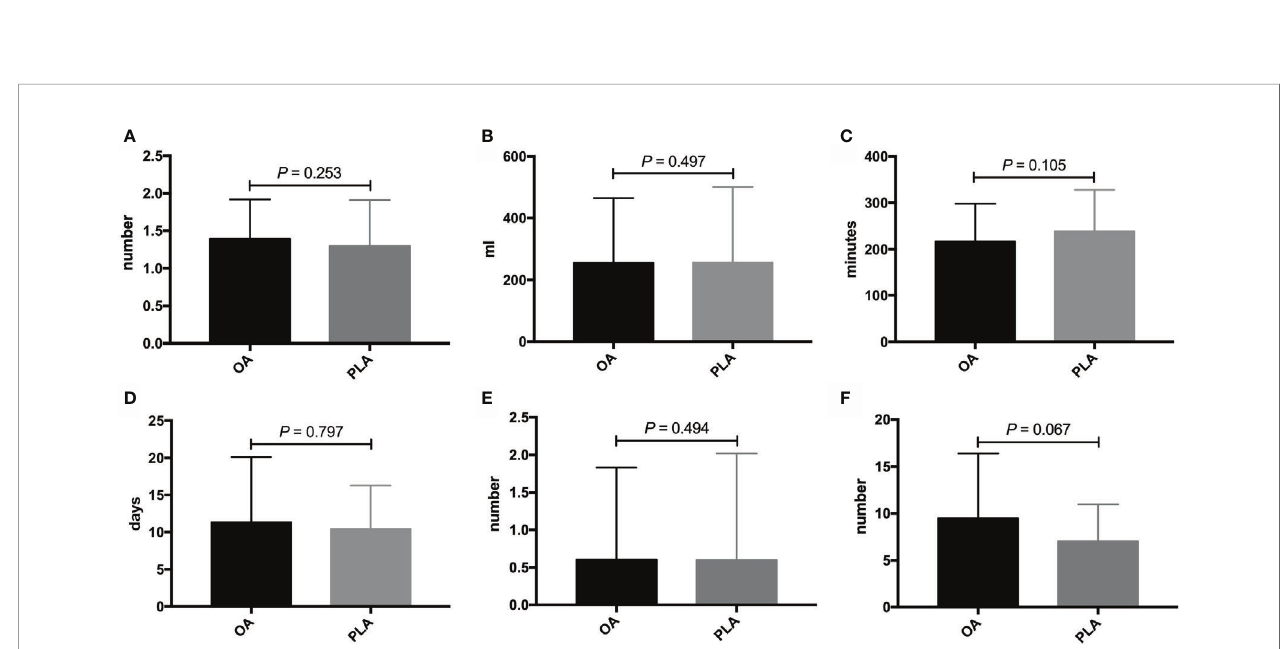
FIGURE 5 | Comparisons of secondary outcomes after OA or PLA in GBC patients. The difference of (A) intraoperative drainage placement, (B) intraoperative blood loss, (C) operation time, (D) postoperative hospitalization, (E) positive LNs, and (F) total harvested LNs. OA, open approach; PLA, primary laparoscopic approach; GBC, gallbladder cancer; LNs, lymph